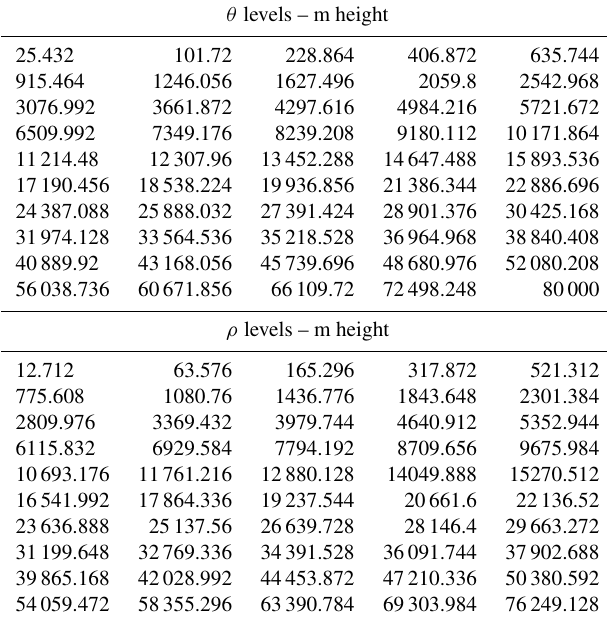
Table A2. Vertical level heights used in our Mars set-up. Values are given for a point at areoid height. This format allows for higher resolution at the surface.